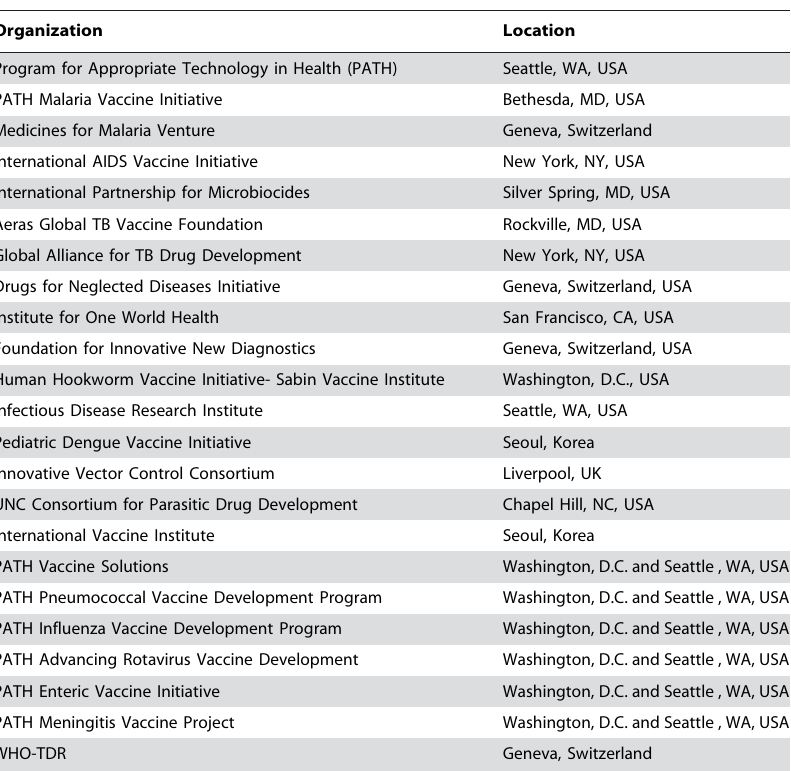
Table 3. A Listing of the Major PDPs for Global